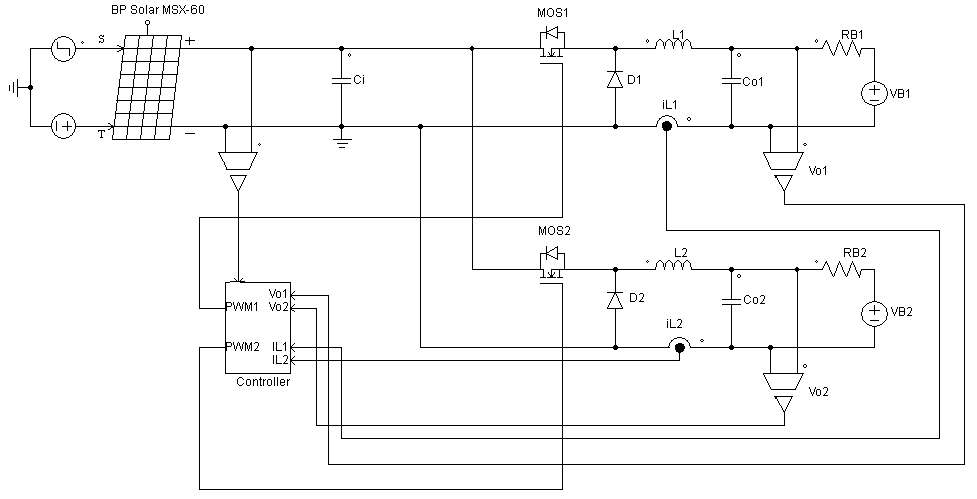
Figure 18. I-V and P-V standard test conditions (STC) curves of BP-Solar MSX-60 solar array.